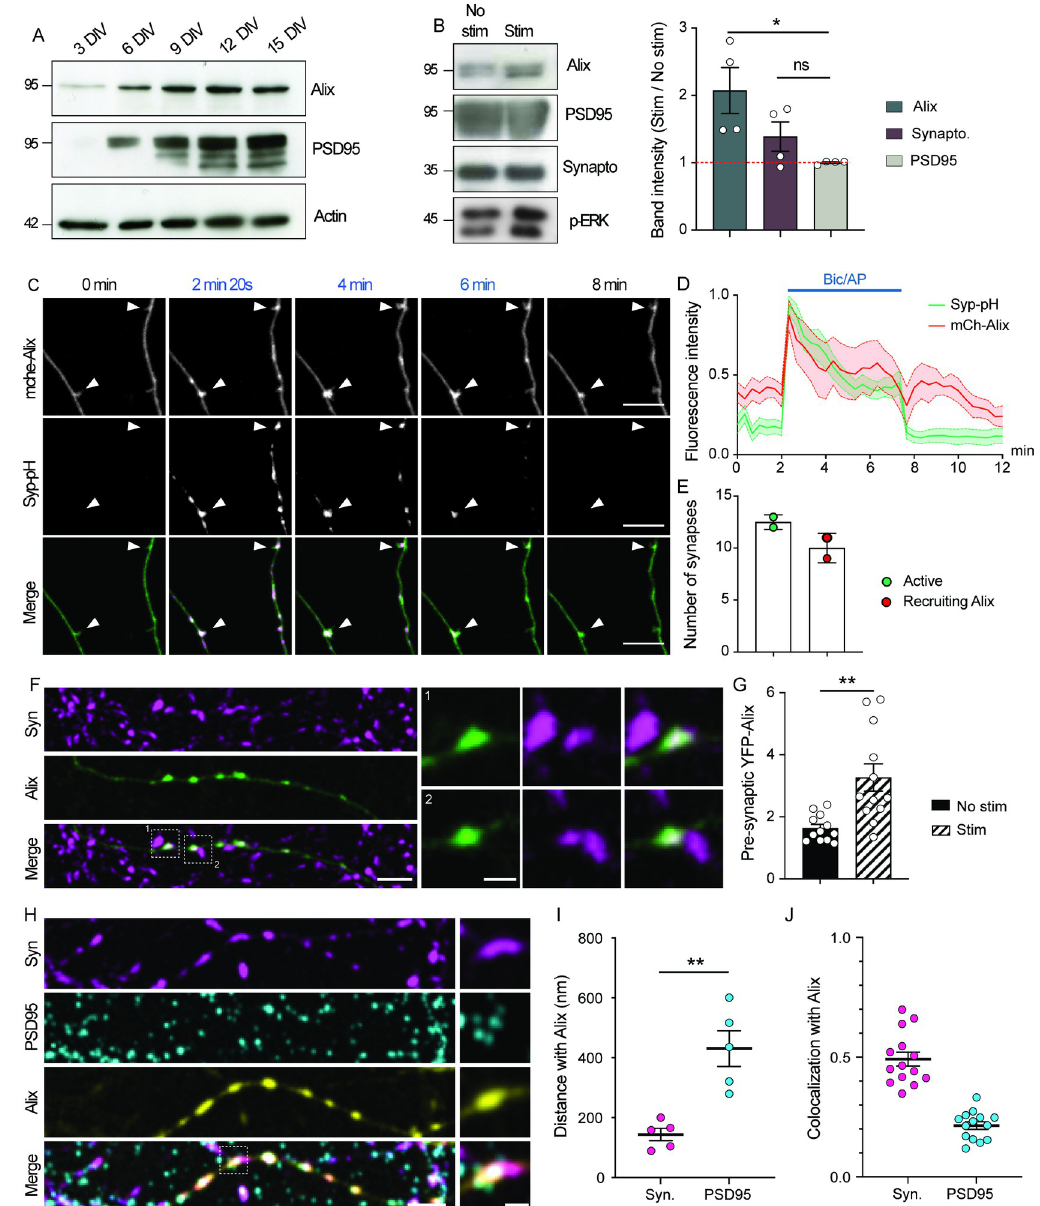
Fig 1. Alix is recruited presynaptically during synaptic activation. ( A ) Western blot analysis of cortical neurons cultured for 3 to 15 DIV demonstrates the increase in Alix expression correlating with synaptogenesis as illustrated by the increase in PSD95 expression. ( B ) Western blot analysis of the increase of Alix in synaptosome-enriched neuronal membranes upon neuronal stimulation by Bic/4AP. Synaptophysin and PSD95 were used as pre- and postsynaptic markers, respectively. The phosphorylated form of ERK (p-ERK) assessed the efficiency of the stimulation. ( C ) Images from time-lapse video microscopy of 15 DIV hippocampal neurons expressing both mche-Alix and Syp-pH stimulated between 2 and 7 min with Bic/4AP. White arrowheads indicate presynaptic boutons where Alix is recruited during stimulation. Scale bar: 10 μ m. ( D ) mche-Alix and Syp- pH fluorescence variation at presynaptic boutons during Bic/4AP incubation (blue line). ( E ) Number of synapses responding to Bic/AP stimulation (Syp-pH increase) and recruiting Alix (mche-Alix increase). ( F ) 15 DIV hippocampal neurons expressing Alix-YFP (green) were stimulated for 5 min with Bic/4AP before fixation and stained with anti-synapsin-1 antibody (Syn, magenta). Dashed white squares indicate insets 1 and 2. Scale bars: 5 and 1 μ m (inset). ( G ) Graph shows the presynaptic increase in Alix-YFP upon stimulation. Presynaptic Alix-YFP corresponds to the ratio of YFP fluorescence between synapsin-positive and synapsin-negative axonal regions. ( H ) Selective recruitment of Alix to the presynaptic part on synapses: 15 DIV hippocampal neurons expressing Alix-YFP (yellow) were stimulated for 5 min before fixation and stained with anti-synapsin-1 antibody (Syn, magenta) and anti-PSD95 (postsynaptic, cyan). Dashed white square indicates the inset on a single